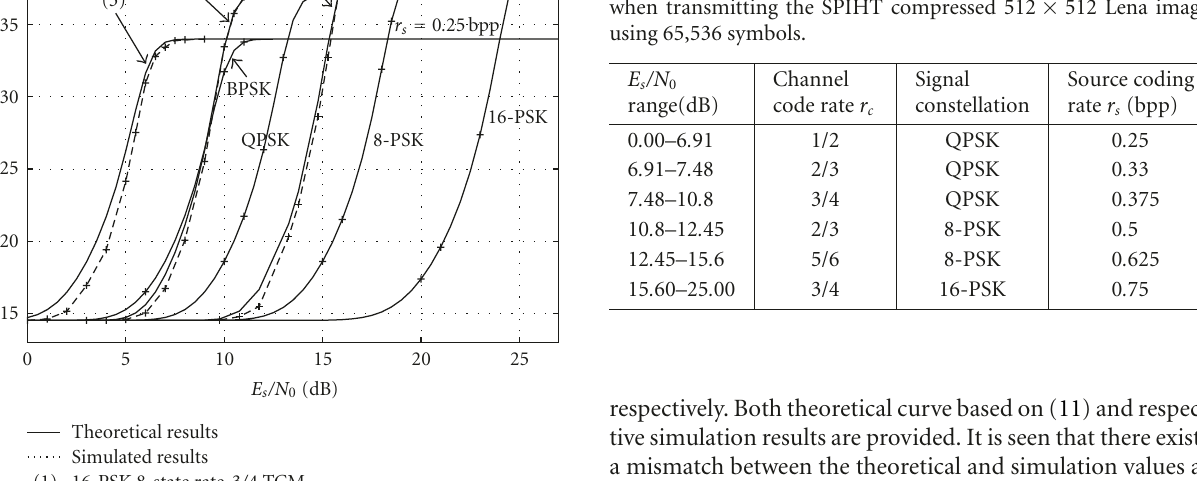
512 Lena image (cid:0)